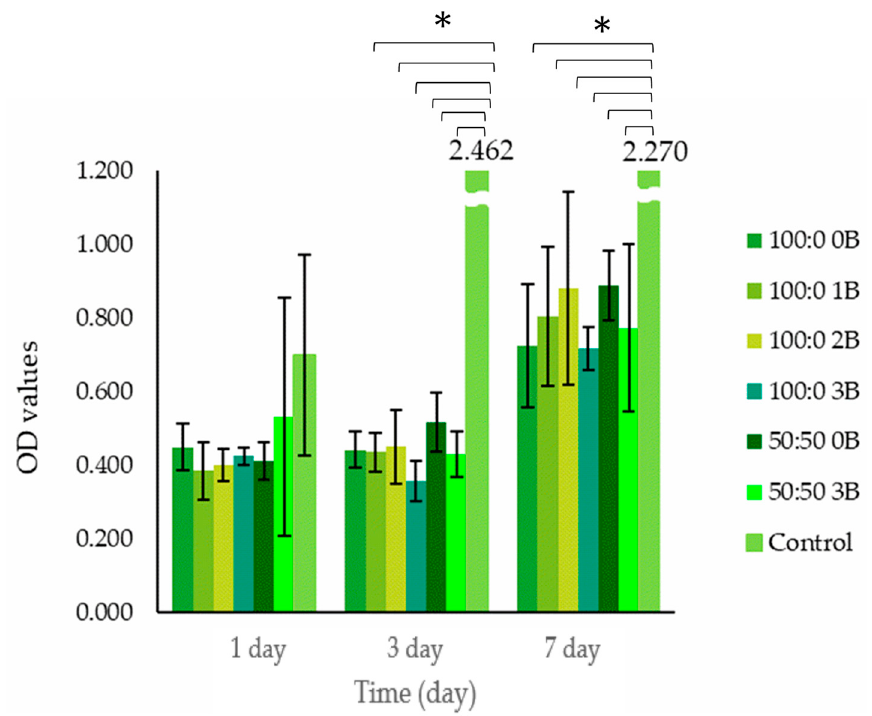
Figure 6. Cell viability of MG63 cells seeded on cryogel scaffolds and cultured up to 7 days, assessed via CCK-8 assay (signi fi cance was determined via ANOVA test (* p < 0.05)).